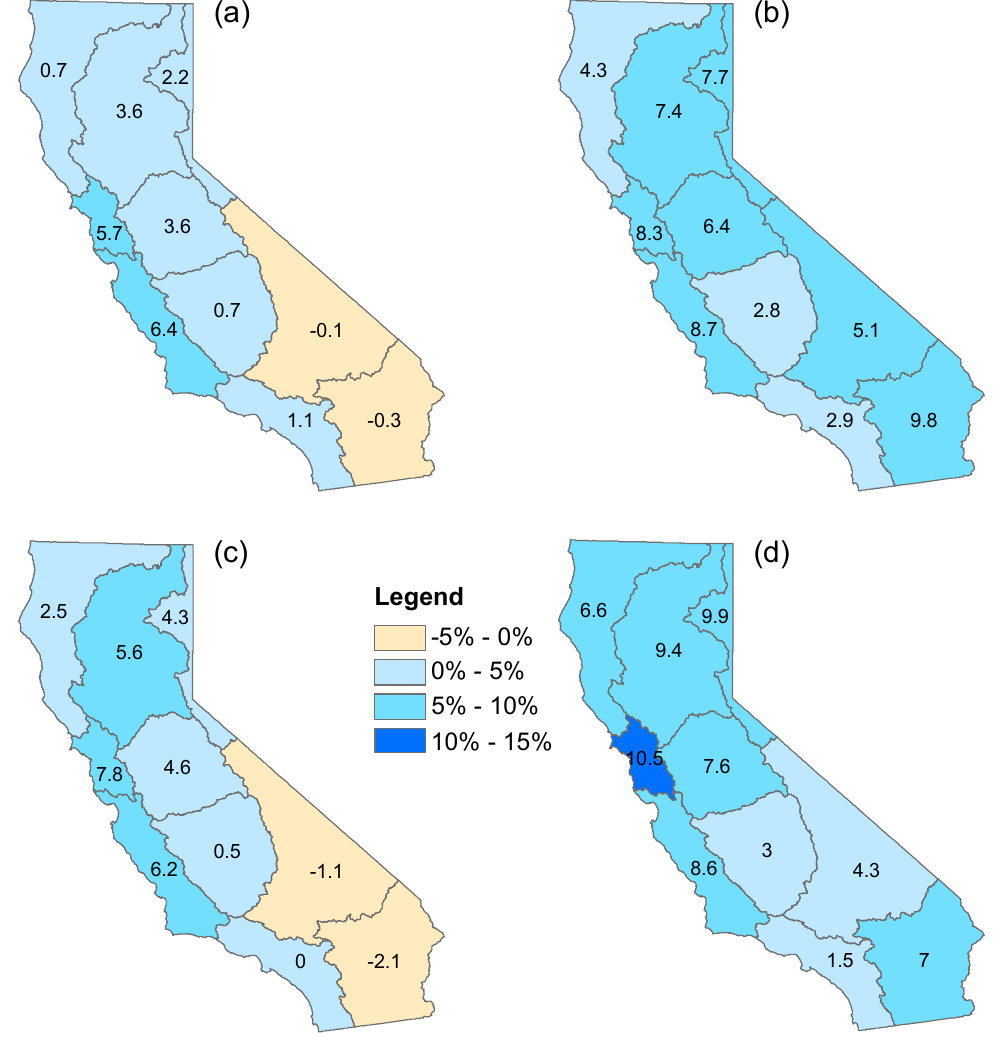
Figure 4. Percent differences (%) between historical and mean RCP 4.5 projections on: ( a ) annual precipitation in mid- century; ( b ) wet season precipitation in mid-century; ( c ) annual precipitation in late-century; and ( d ) wet season precipitation in late-century. Table 3. Percent differences (%) between historical and mean RCP 8.5 projections on annual precipitation and wet season precipitation.